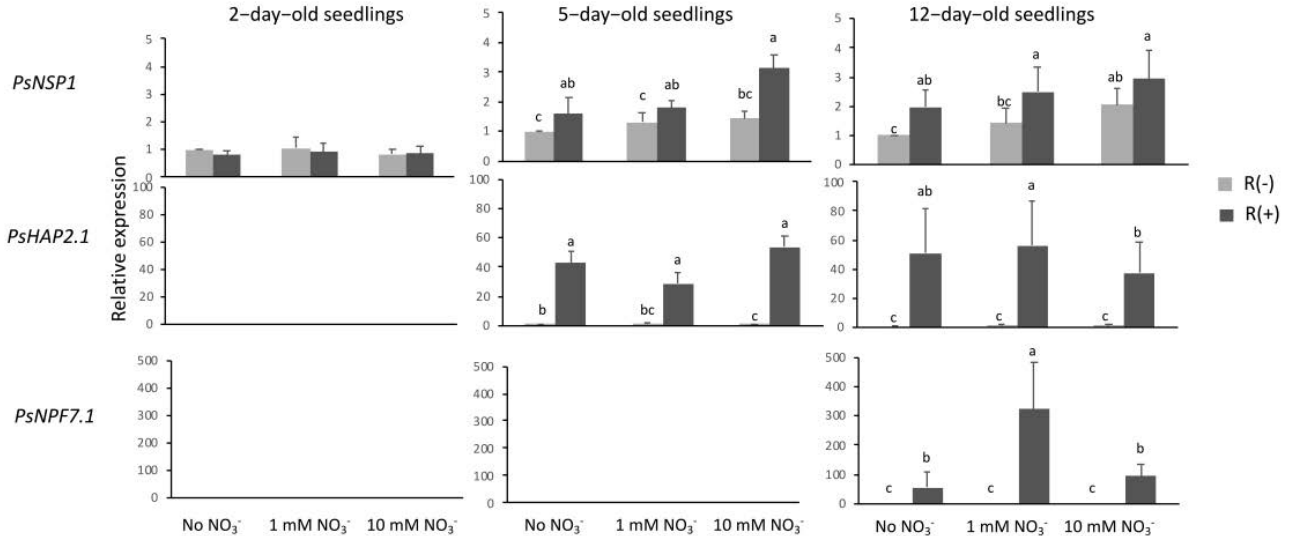
Figure 1. Relative expression of genes involved in the nodulation process. RT-qPCR experiments were performed with root RNAs from 2-, 5-, or 12-day-old seedlings grown in MS without NO 3 − or with 1 mM or 10 mM NO 3 − , with [R(+)] or without Rhizobium [R(–)] using actin and β -tubulin as reference genes. PsNSP1 , nodulation signaling pathway; PsHAP2.1 , transcription factor of the CCAAT-binding family; PsNPF7.1 , (NRT1/PTR Family 7.6). Data presented are means of three independent experiments performed in triplicate. Error bars indicate SE. Letters denote significant differences at the 0.05 level (multiple